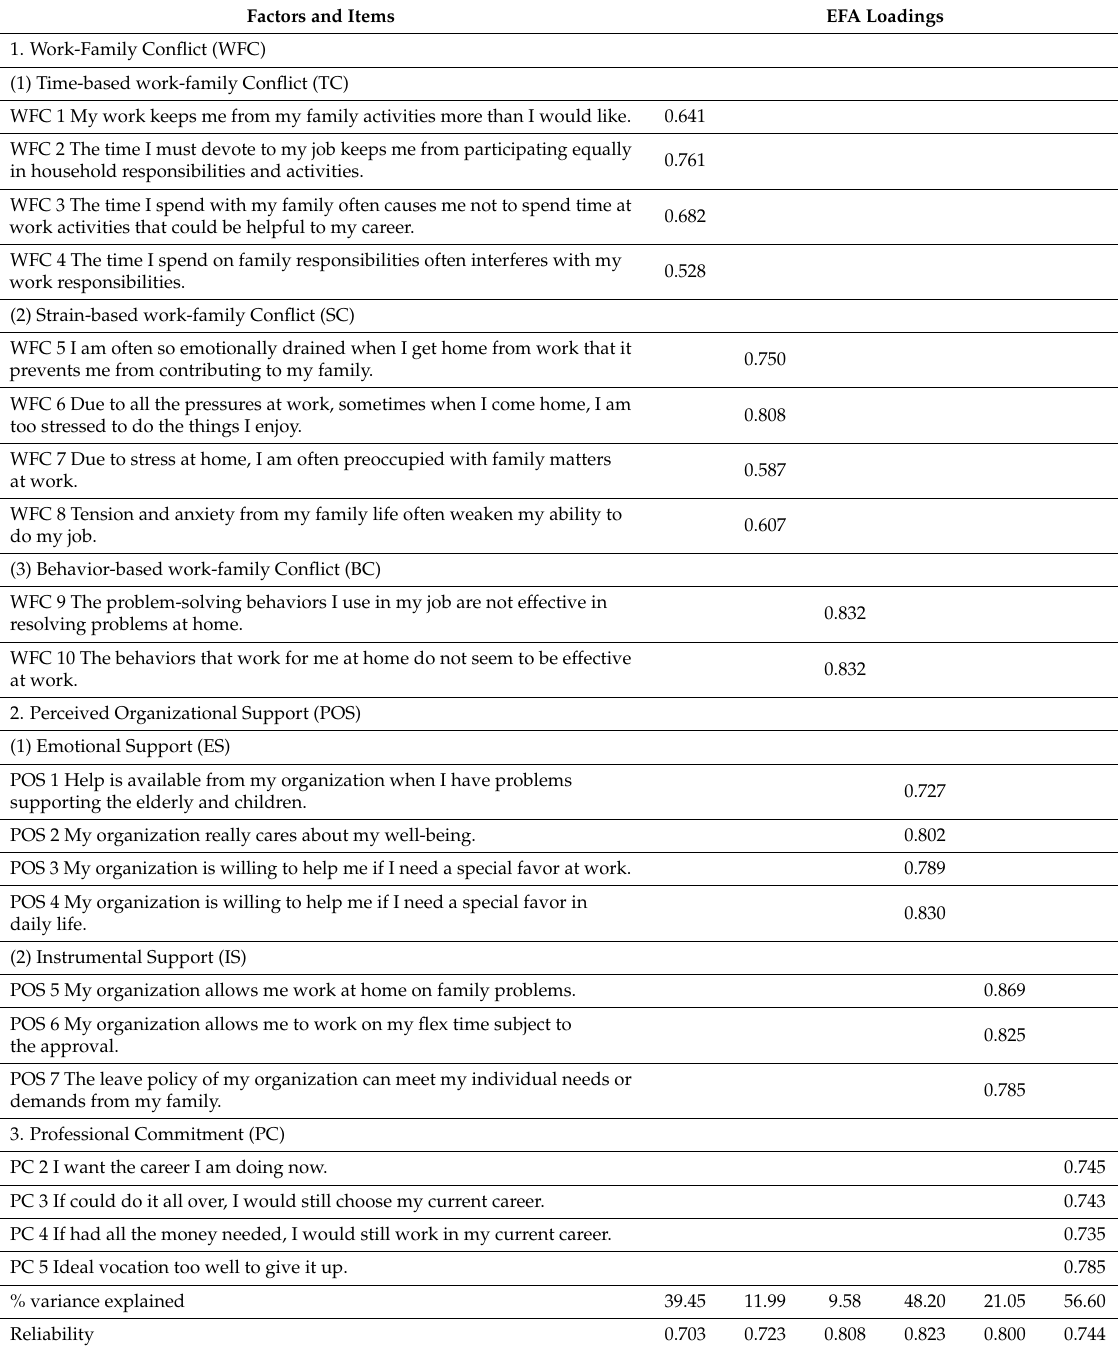
Table 2. Exploratory factor analysis